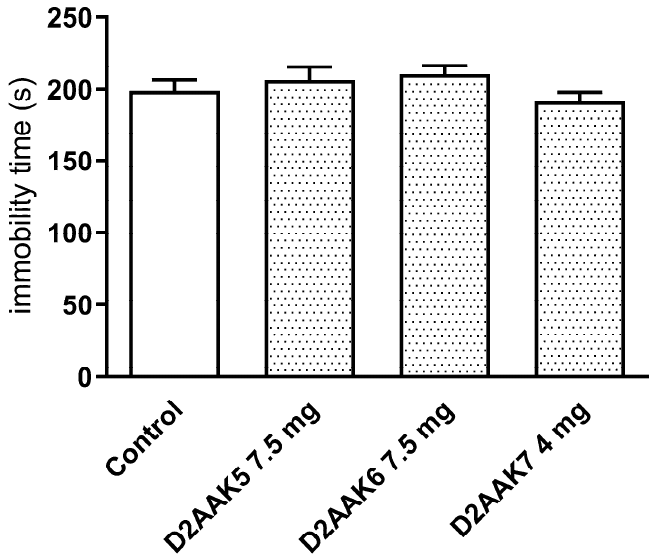
Figure 11. The influence of D2AAK5, D2AAK6 (7.5 mg/kg), and D2AAK7 (4 mg/kg) on the total duration of immobility in the FST in mice. The investigated compounds were administered i.p. 60 min before the test. The values represent means ± SEM of the one independent experiment.